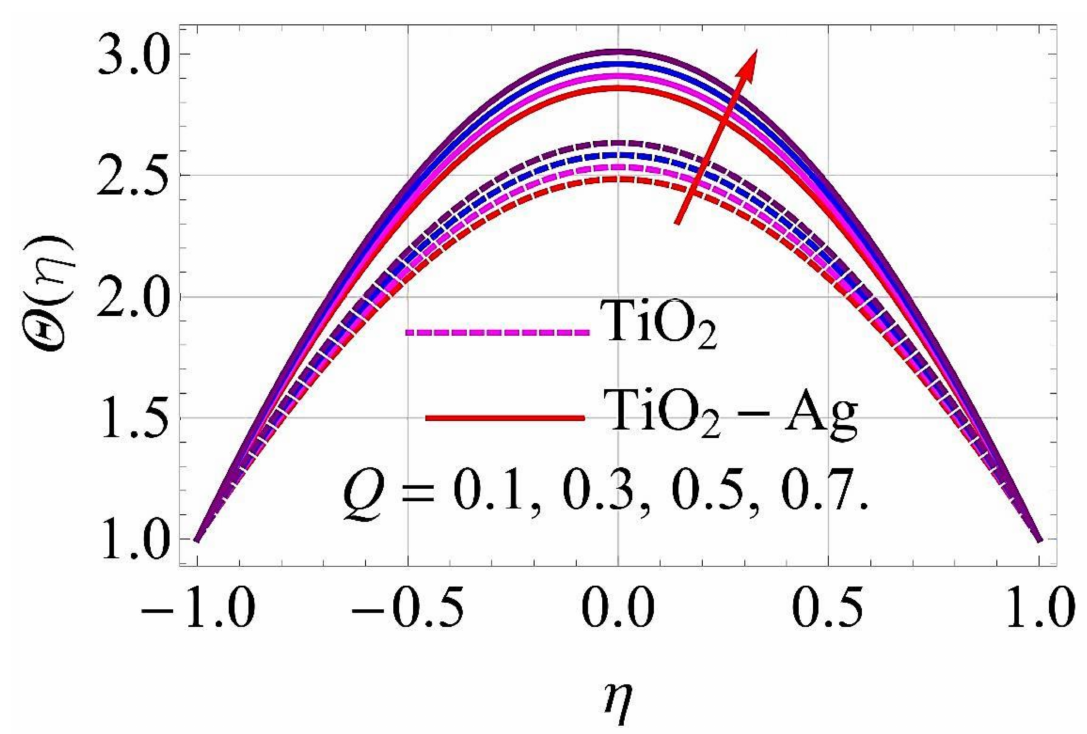
Figure 21. Temperature versus Q with α = − 5 ◦ for converging/stretching circumstances. When Re = 25, φ 1 = φ 2 = 0.01, Rd = 0.4, Ec = Ha = k ∗ = Fr = K 1 = 0.1.